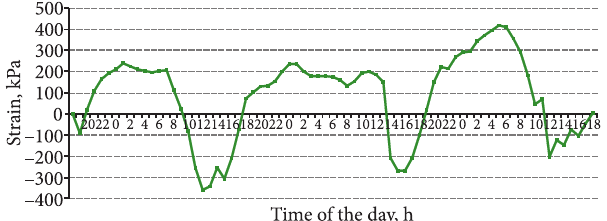
Fig. 18. Mode of deformation for the upper asphalt concrete layer – stresses during the days max positive temperatures (scheme in Fig.